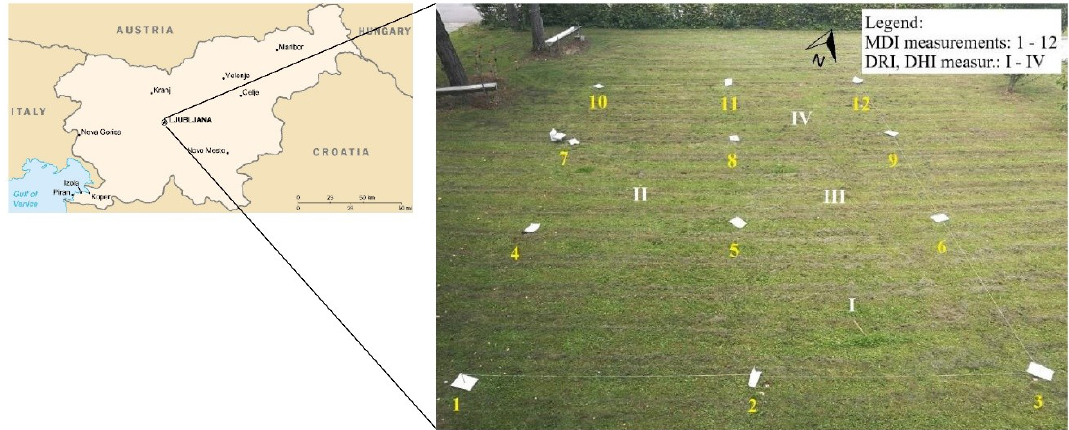
Figure 1. Study plot with measurement locations.